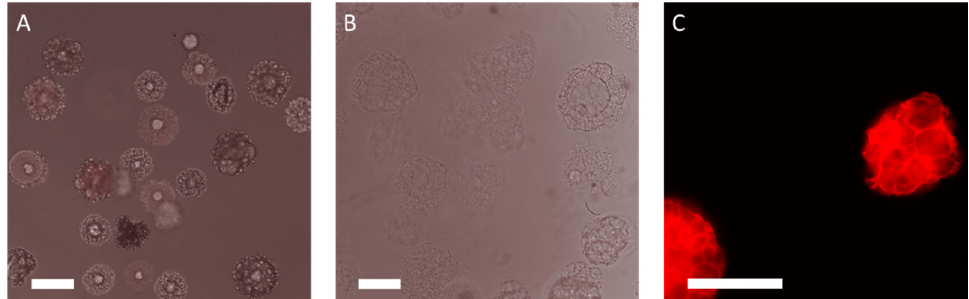
Figure 3. Fluorescent microphotographs of the MCs prototypes. ( A ) BR13 (negative control): poly( D , L -lactide-co-glycolide) (PLGA) MCs without gelatin after reaction with the CF633 dye, exposure time: 400 ms, no fluorescence in the red channel. Magnification 100×, scale bar 150 µm. ( B ) BR44 no staining with the CF633 dye (negative control), no fluorescence in the red channel. Magnification 100×, scale bar 150 µm. ( C ) BR44 reaction with the CF633 dye, exposure time: 400 ms. Magnification 200×, scale bar 150 µm.